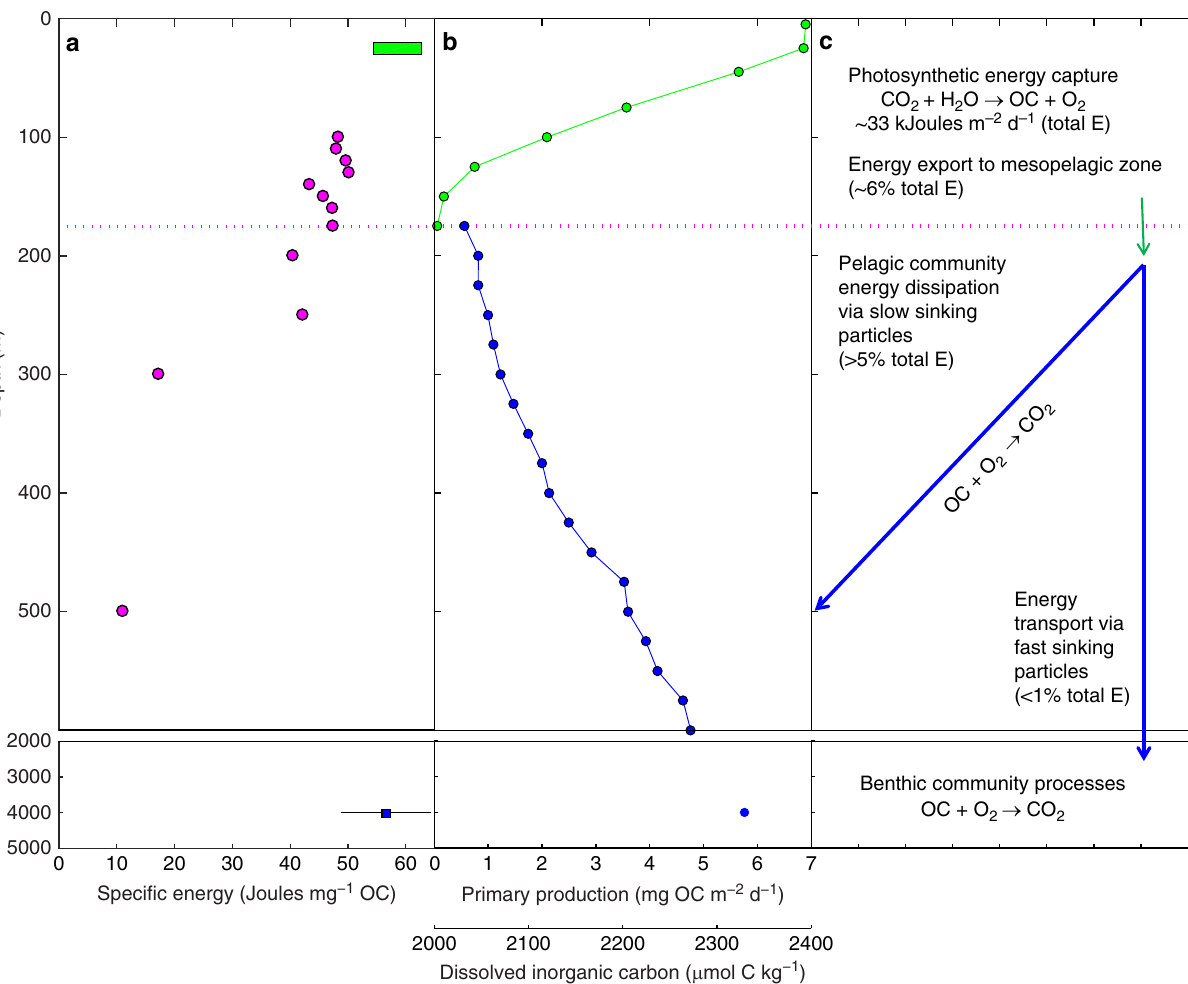
Fig. 3 Energy capture, fl ux, and dissipation. a Carbon and energy fl ux processes showing speci fi c energy of photosynthetic production (green bar), depth- dependent changes in energy of SPM as particles sink and age (magenta symbols) and mean ± s.d. speci fi c energy for SPM collected at 4000 m (blue symbol). The horizontal magenta dotted line at 175 m depicts the photosynthetic compensation irradiance (see text for details). b Pro fi les of photosynthetic production (green symbols) and concentration of dissolved inorganic carbon (blue symbols) at Station ALOHA. c Schematic representation of the major processes controlling carbon and energy fl uxes at Station